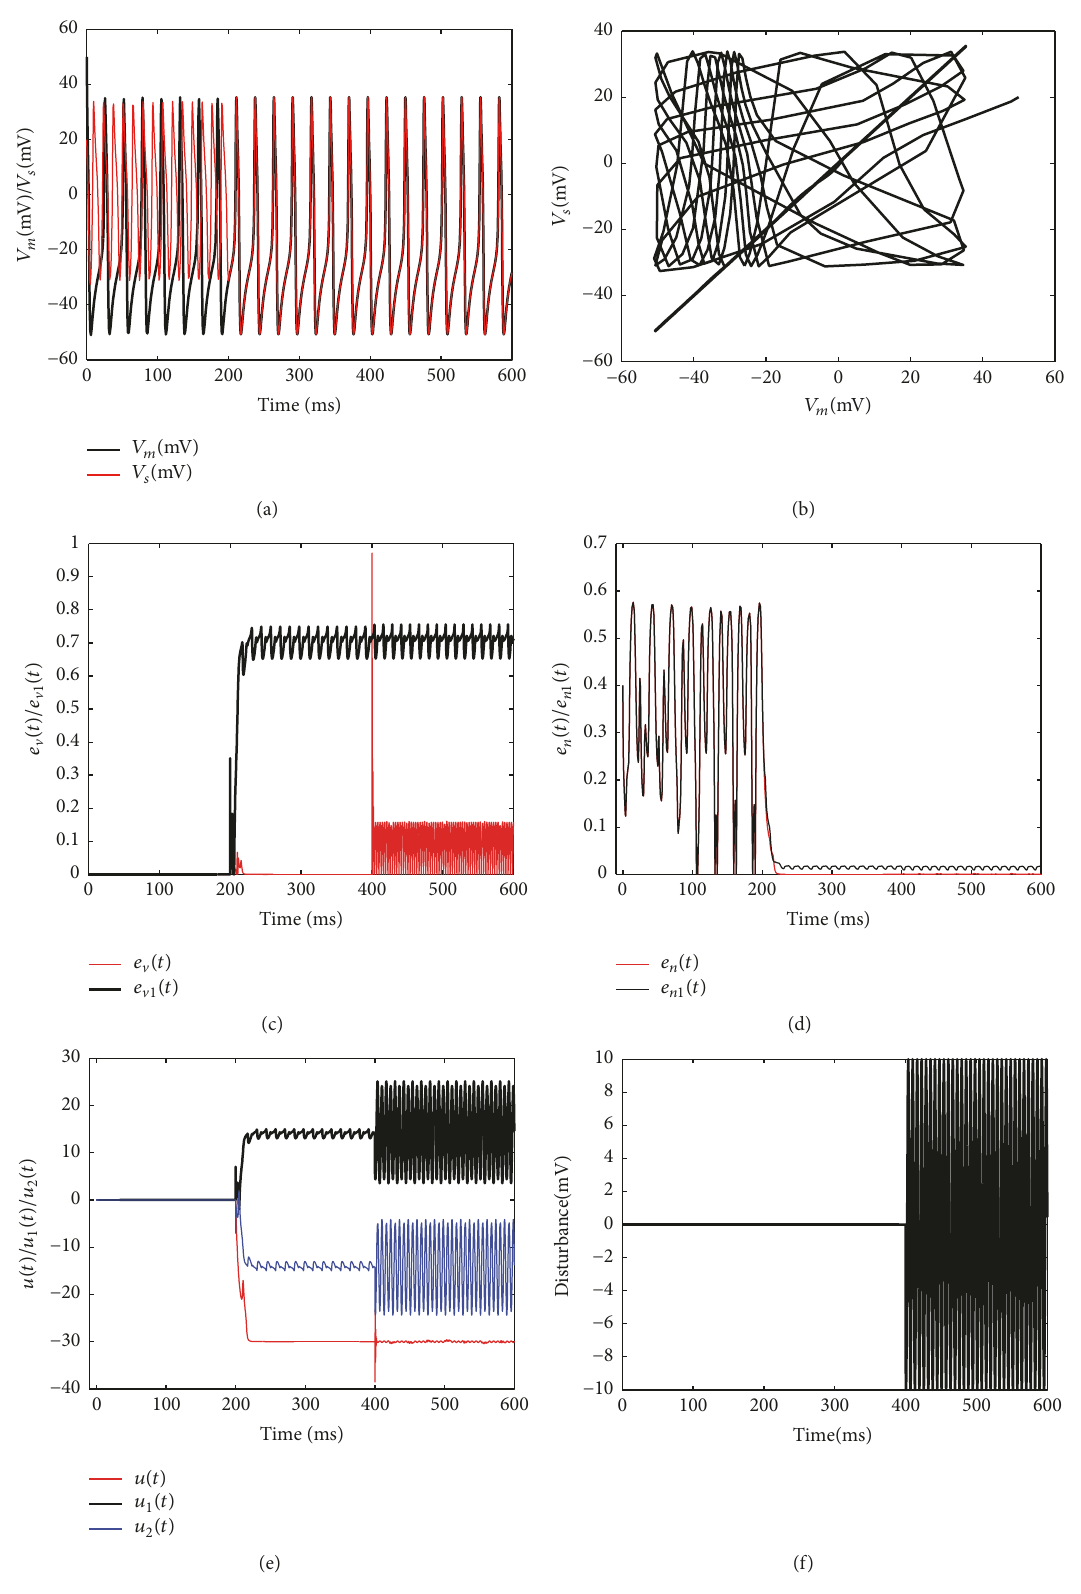
Figure 4: Synchronous response of Morris-Lecar neurons and the comparisons of control inputs (in presence of sinusoidal